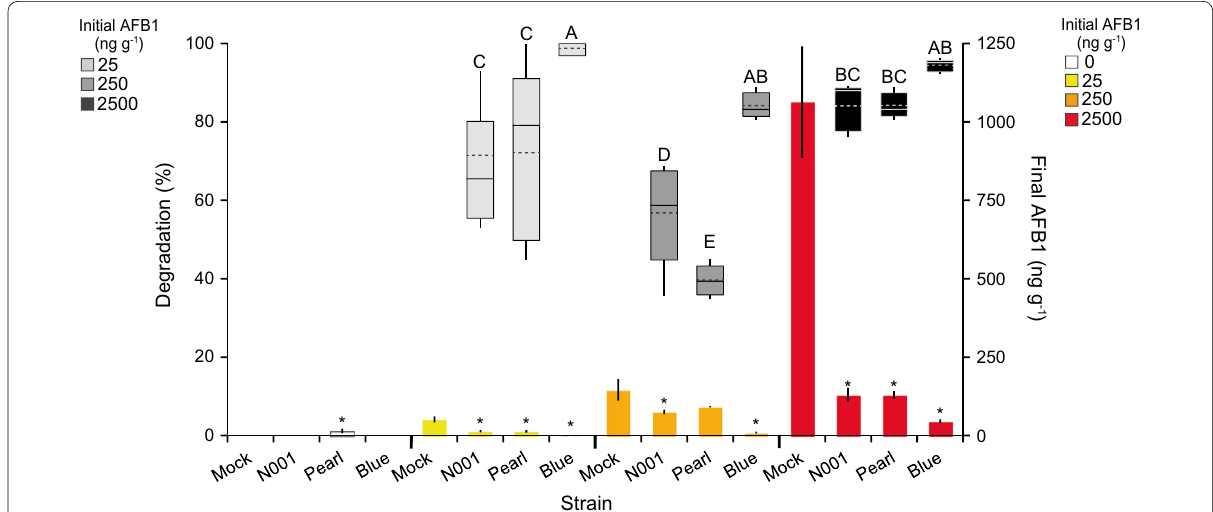
Fig. 1 Degradation of AFB 1 by P. ostreatus. Box plots show the percentage of AFB 1 degraded ( left axis ) by P. ostreatus strains grown on uncontami- nated (0 ng/g) or contaminated maize at 25, 250 and 2500 ng g − 1 AFB 1 , respectively. Bars show raw AFB 1 concentrations ( right axis ) of treated (N001, Pearl and Blue) or untreated (mock) samples. Whiskers on box plots show the minimum and maximum values and means are indicated by dashed lines . Box plot values not connected by the same letter are significantly different ( p 0.05) by Tukey’s HSD. Whiskers on bars indicate standard ≤ errors. Asterisks above bars show significant difference ( p 0.05) by Tukey’s HSD of treated values compared to controls of the same initial AFB 1 ≤